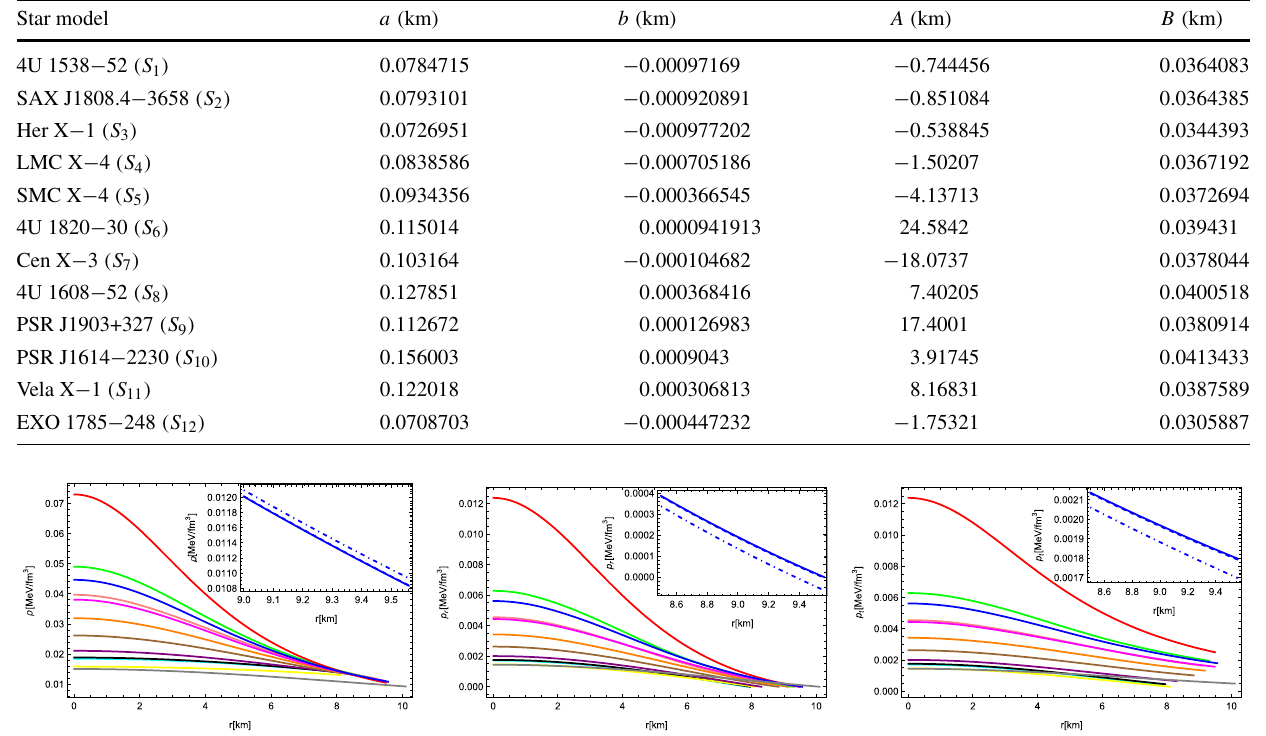
Table 2 Approximated values of output parameters with α = 1 . 3 × 10 − 11 Star model